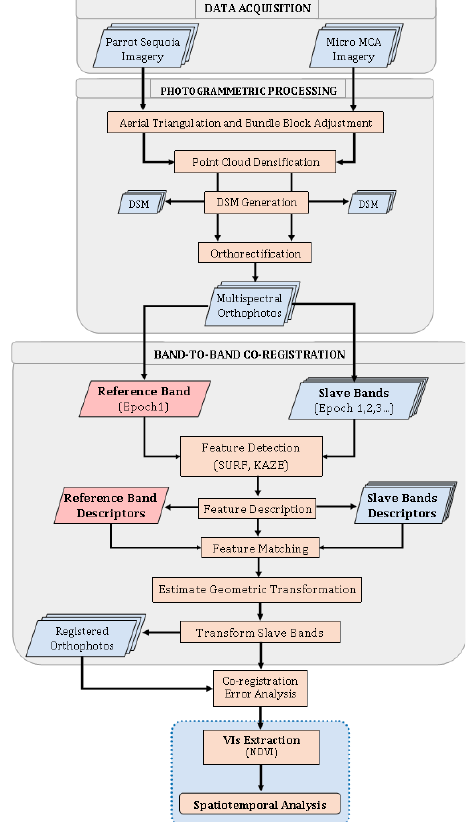
Figure 4. Flowchart showing an overview of the methodology